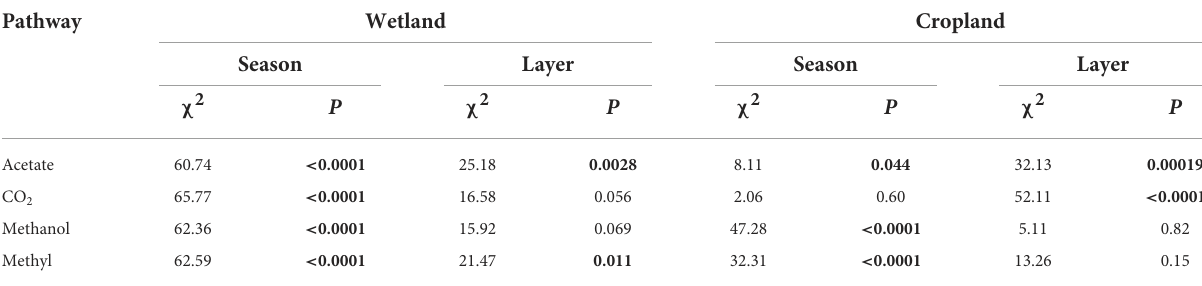
TABLE 1 The Kruskal–Wallis test of functional genes in four pathways. Pathway Wetland